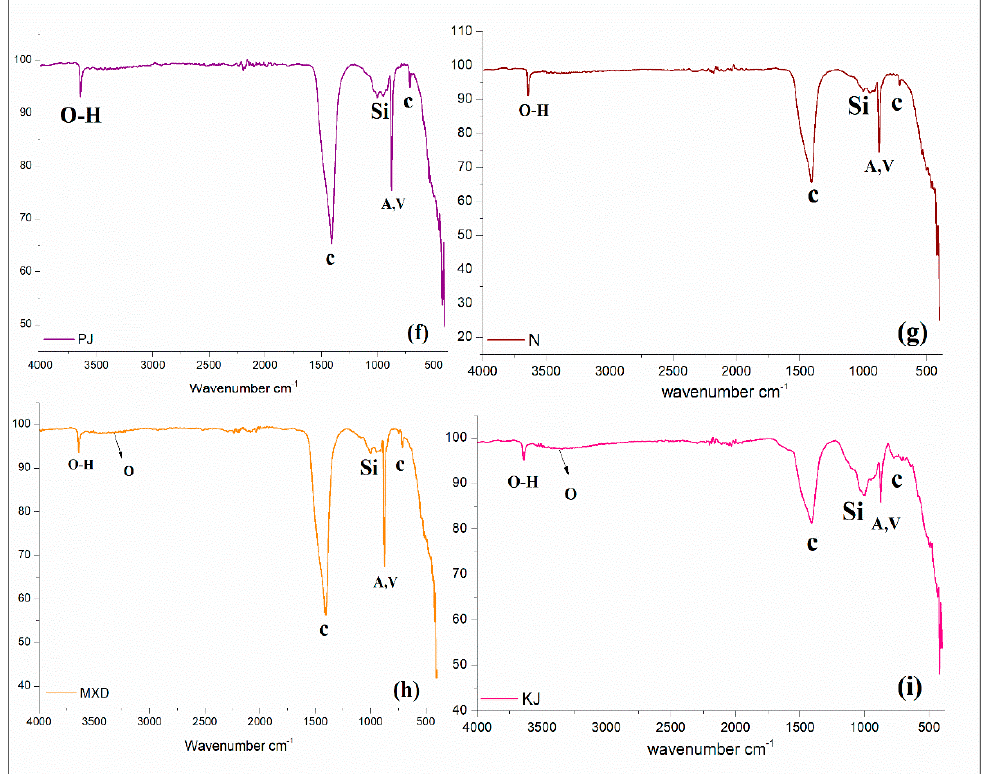
Figure 6. FTIR patterns at 56 days: ( a ) reference lime mortar; ( b ) kadukkai lime mortar; ( c ) cactus lime mortar; ( d ) hibiscus lime mortar; ( e ) aloe vera lime mortar; ( f ) jaggery mortar; ( g ) neelamari lime mortar; ( h ) kadukkai + jaggery mortar; and ( i ) kadukkai + jaggery + aloe vera (MXD) mortar.